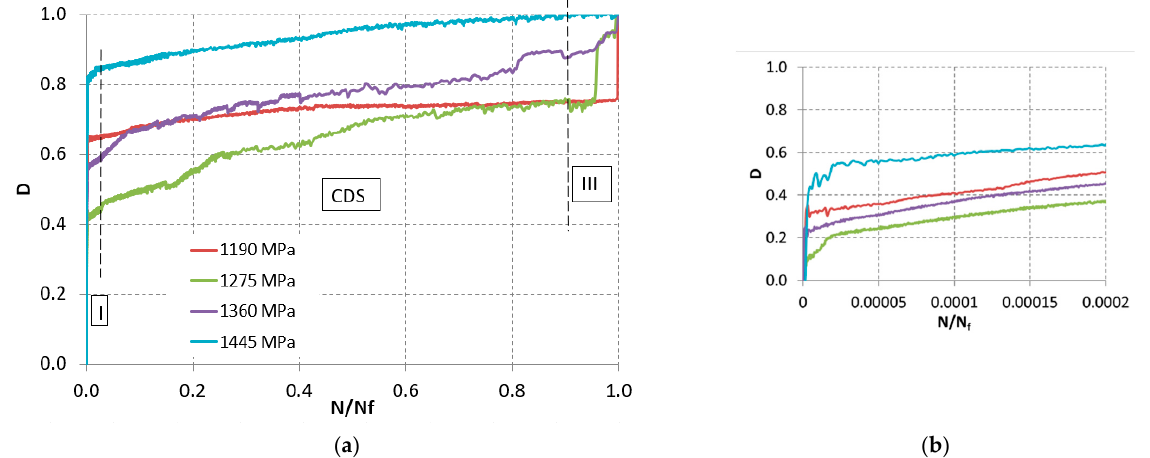
Figure 6. Evolution of the damage index: ( a ) global; ( b ) detail of the first cycles. Figure 6 shows